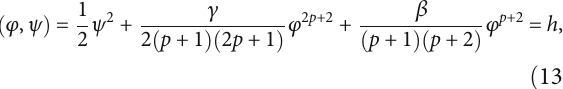
ð ξ Þ when κ = 0, p = 9, α − c = 0, γ = 1 , and β ⟶ 0 − 0 . 1